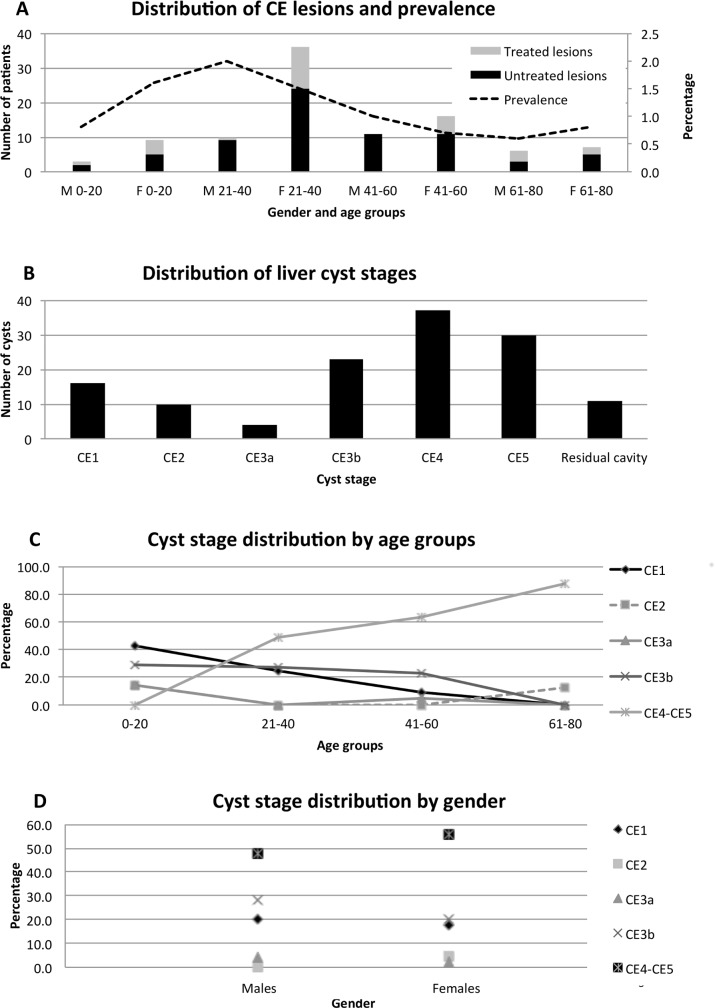
Distribution of CE lesions.A. Number of subjects with untreated and previously treated CE cysts (bars; left Y axis) and overall prevalence of CE in the screened population (dotted line; right Y axis) according to gender and age group (X axis). M = males; F = females. Age groups are expressed in years. Three children (aged 3, 8 and 9 years) and 19 adults (aged 81–94 years) were outside the target age range target; none of these subjects were infected with CE. B. Number of hepatic CE cysts in different stages. C. Percentage of CE cyst stages in patients never previously treated for CE within age groups. D. Percentage of CE cyst stages in patients never previously treated for CE within gender groups.